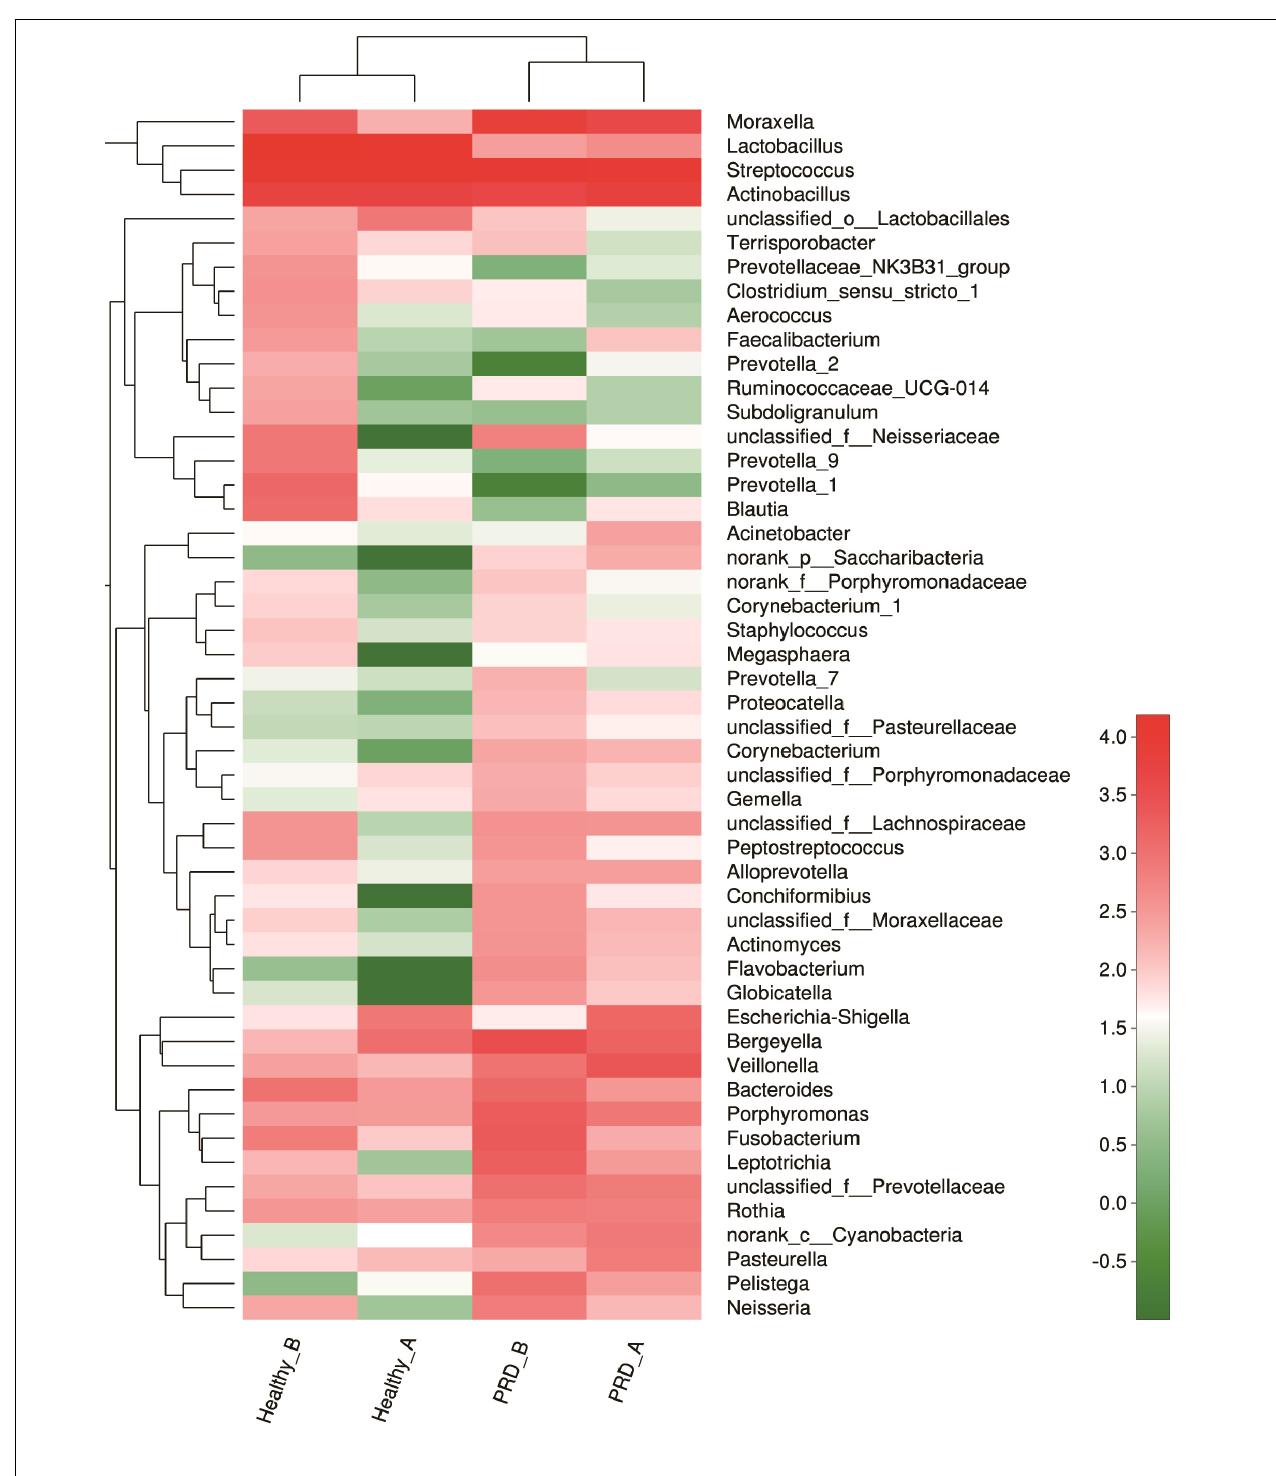
FIGURE 4 | Heatmap analyses of abundant genera in each group (top 50). The bacterial phylogenetic tree was calculated using the neighbor-joining method and the relationship among the four groups was determined by Bray–Curtis distance. The heatmap plot depicts the relative percentage of each bacterial genera (variables clustering on the vertical-axis) within each group (horizon-axis clustering). The color of the spots in the right panel represents the relative values (lg) of the genera in each group.